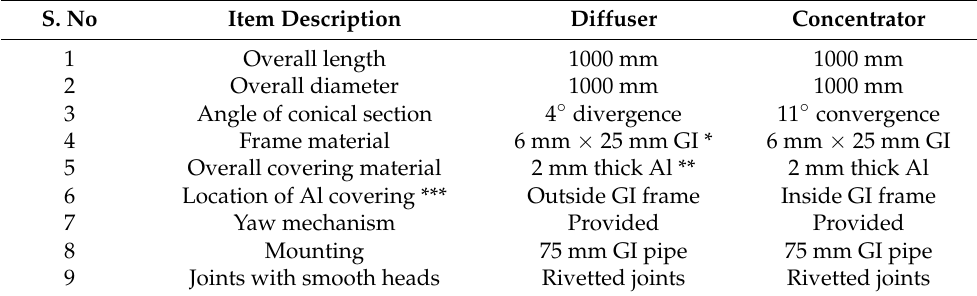
* GI—galvanized iron; ** Al—aluminum. *** Since the interaction of the wind with the concentrator occurred inside the concentrator, a smooth surface was ensured inside by placing the Al covering inside the GI frame of the